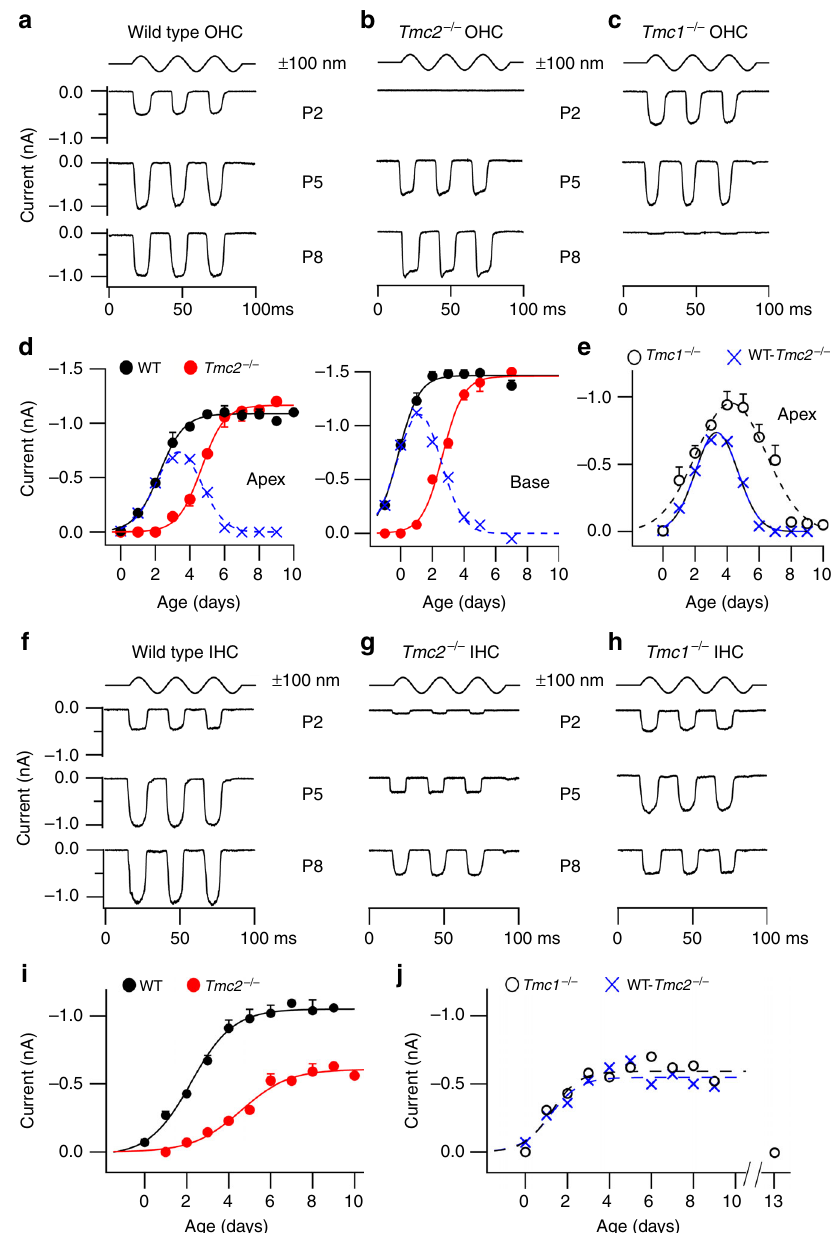
Fig. 1 Contribution of TMC2 to development of mechanotransduction in OHCs and IHCs. a Examples of maximum MET currents of wild-type apical OHCs during the fi rst postnatal week, ages P2, P5, and P8. Top trace denotes timing of 100 nm amplitude sinusoidal vibration of the hair bundle evoked by a fl uid jet stimulator. b MET currents in Tmc2 − / − in apical OHCs. c MET currents in Tmc1 − / − mouse apical OHCs. d MET current amplitudes (mean ± SEM) in wild type (WT; black symbols) and Tmc2 − / − (red symbols) in OHCs from cochlear apex and base. Numbers of OHCs for points with increasing age: apex WT, 13, 6, 5, 8, 6, 6, 5; apex Tmc2 − / − , 3, 3, 3, 5,7, 5, 6, 3, 3; apex Tmc1 − / − : 3, 8, 5, 4, 7, 9, 3, 6, 8, 6, 3; base WT: 7, 7, 4, 7, 9, 12, 7, 3; base Tmc2 − / − : 3, 3, 4, 5, 5, 4, 4, 3. e Expression of TMC2 in apical OHCs, derived as the difference between wild type and Tmc2 − / − (crosses) and from Tmc1 − / − mice (open symbols); points fi t with Gaussian curves. Numbers of cells: WT, 5 to 13; Tmc2 − / − mice 3 to 7. Tmc1 − / − mice 5 to 7. f Examples of maximum MET currents during development of wild type apical IHCs at postnatal ages P2, P5 and P8. g MET currents during same period in apical IHCs from Tmc2 − / − mice. h MET currents in apical IHCs from Tmc1 − / − mice at postnatal ages P2, P5, and P8. i MET currents (mean ± SEM) in wild type (black symbols) and Tmc2 − / − (red symbols). j Expression of TMC2 in IHCs, derived as the difference between wild type and Tmc2 − / − (blue crosses, fi t with blue dashed line) and from Tmc1 − / − mice (open symbols, fi t with black dashed line). Numbers of cells, increasing in age: IHC, WT: 5, 10, 6, 10, 6, 6, 5, 4, 4, 4; IHC Tmc2 − / − 3, 9, 11, 8, 6, 7, 6, 5, 3, 3; IHC Tmc1 − / − 3, 4, 5, 3, 4, 5, 4, 4, 4, 4, 3. Holding potential − 84 − / − of ten Tmc2 OHCs, three apical, three middle and four basal Gaussians (Fig. 4). The dominant levels, inferred from the peaks cochlear regions. Transitions between different levels were of the Gaussians, were similar across cells, with current values evident in most recordings (Fig. 4), with each cell showing at (mean ± SD; N = number of cells), at − 84 mV holding potential, least two or more current levels. Current amplitudes in each of of − 4.2 ± 0.3 pA ( N = 3), − 7.1 ± 0.8 pA ( N = 8), − 11.3 ± 0.6 pA the sweeps were compiled into a histogram and fi t with a sum of ( N = 6), − 14.7 ± 1.3 pA ( N = 8), and − 20.5 ± 1.4 pA ( N = 3). The